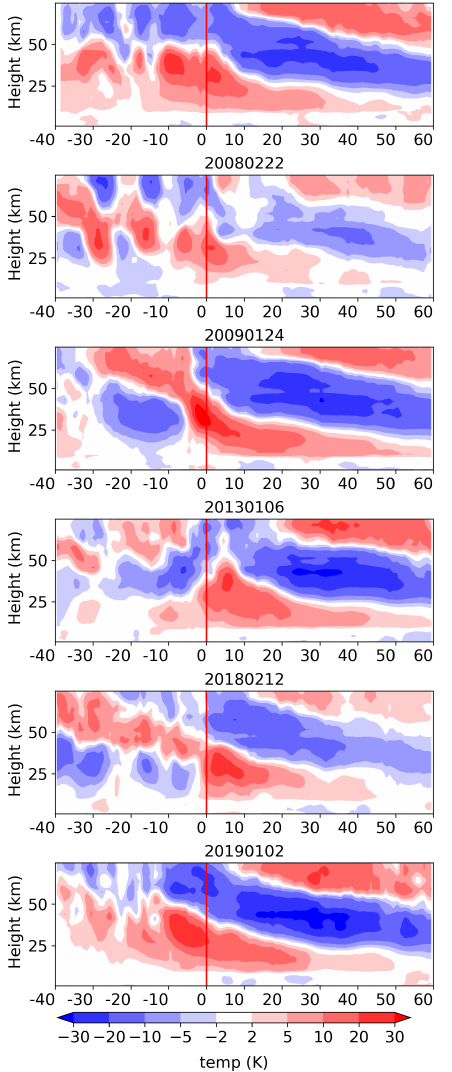
Figure 9. Similar to Fig. 8 but for the temperature anomaly for zonal average.